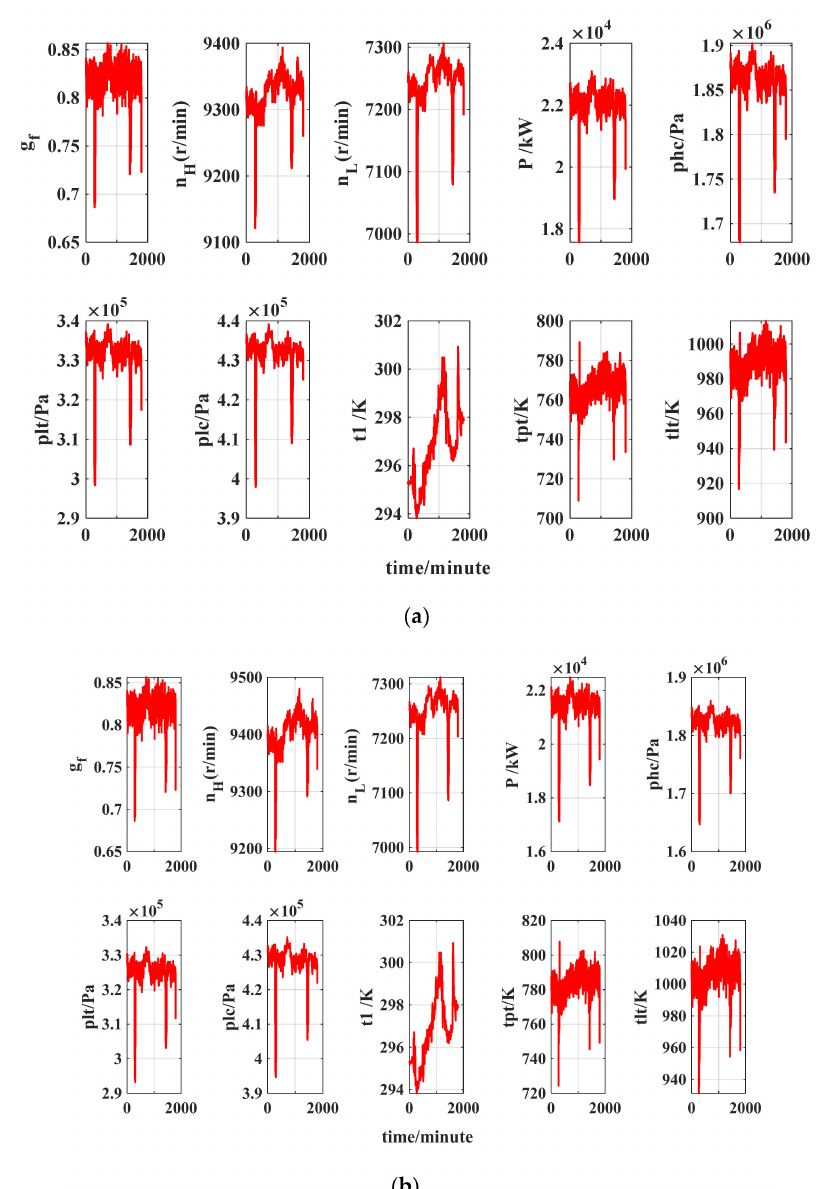
Figure 9. LPC fouling fault data in the experiments: ( a ) LPC fouling fault severity 1; ( b ) LPC fouling fault severity